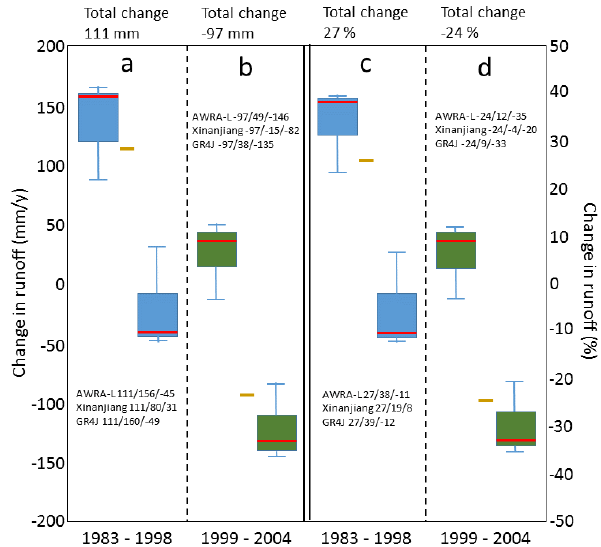
Figure 3. Summary of bushfire impact on annual streamflow from the year 1983 to 2004 in mm (two left panels a and b ) and percent- age (two right panels c and d ) for the salvation Creek catchment. Blue boxplots are bushfire impact from the year 1983 to 1998, and green ones are from the year 1999 to 2004. Within each of the four panels, the yellow dash represents total streamflow change relative to pre-bushfire period, the first boxplot represent vegetation change impact on streamflow and the second boxplot represents climate variability impact on